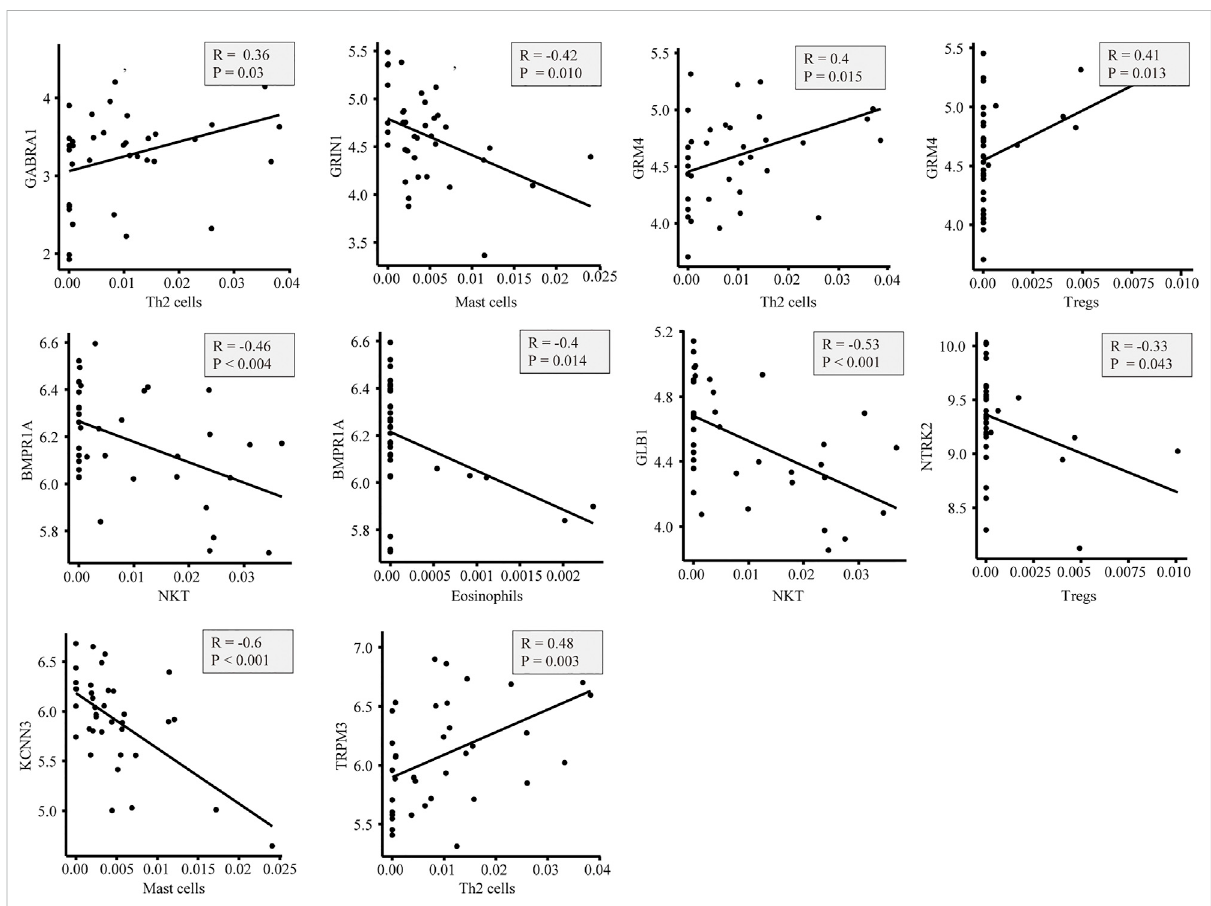
FIGURE 7 Plot of the correlation between eight genes associated with immune cells: there is a close correlation between genes and immune